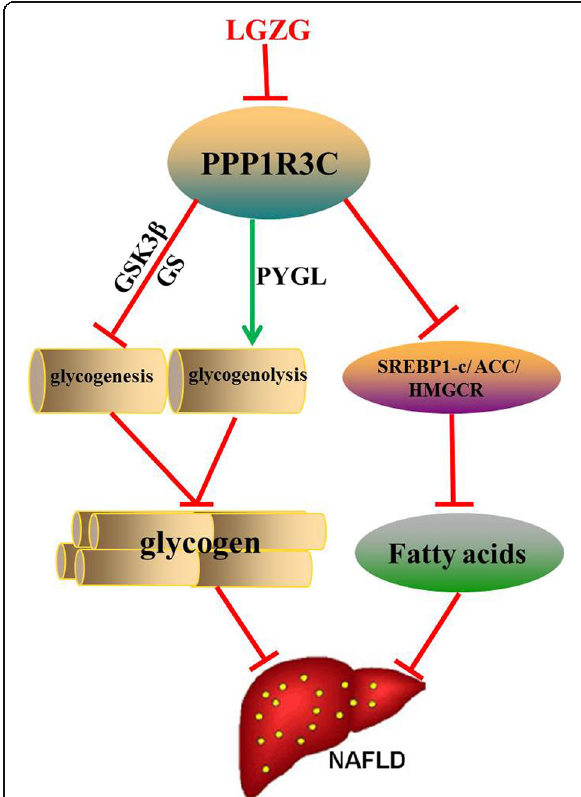
Fig. 6 Summary of the study. Traditional Chinese formulae LGZG inhibited PPP1R3C expression. Low PPP1R3C expression could reduce GS activity, promote PYGL expression, and reduce glycogen storage via inhibiting glycogenesis and accelerating glycogenolysis. In addition, low PPP1R3C expression decreased the nucleic SREBP-1c and the ACC activity, which might induce suppressed lipogenesis in the liver. Thus by inhibiting PPP1R3C mediated molecules, LGZG alleviated NAFLD and related